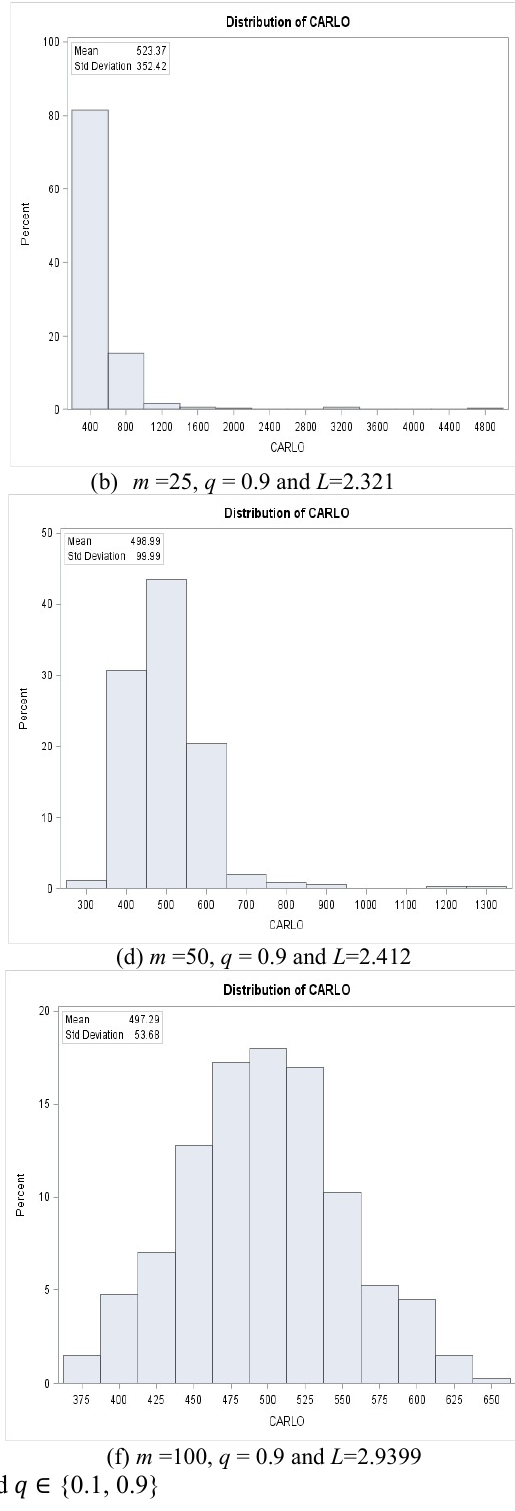
(c) m =50, q = 0.1 and L = 2.583 (d) m =50, q = 0.9 and L =2.412